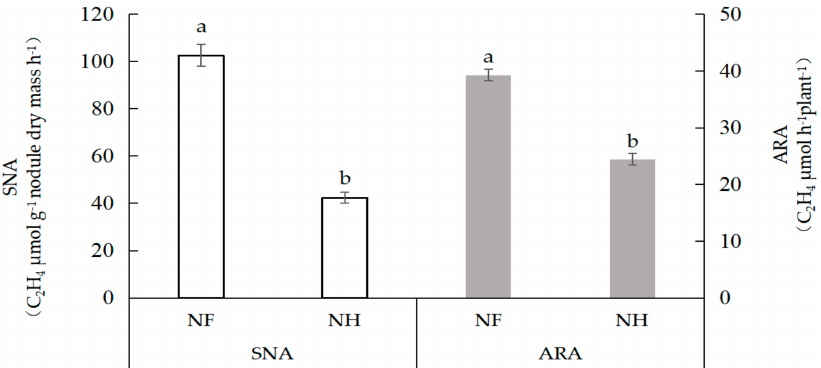
Figure 1. The nitrogenase activity of dual-root soybean nodules. SNA is the specific nitrogenase activity, and ARA is the acetylene reduction activity. Different lowercase letters indicate a significant difference between the treatments at the 5% level.